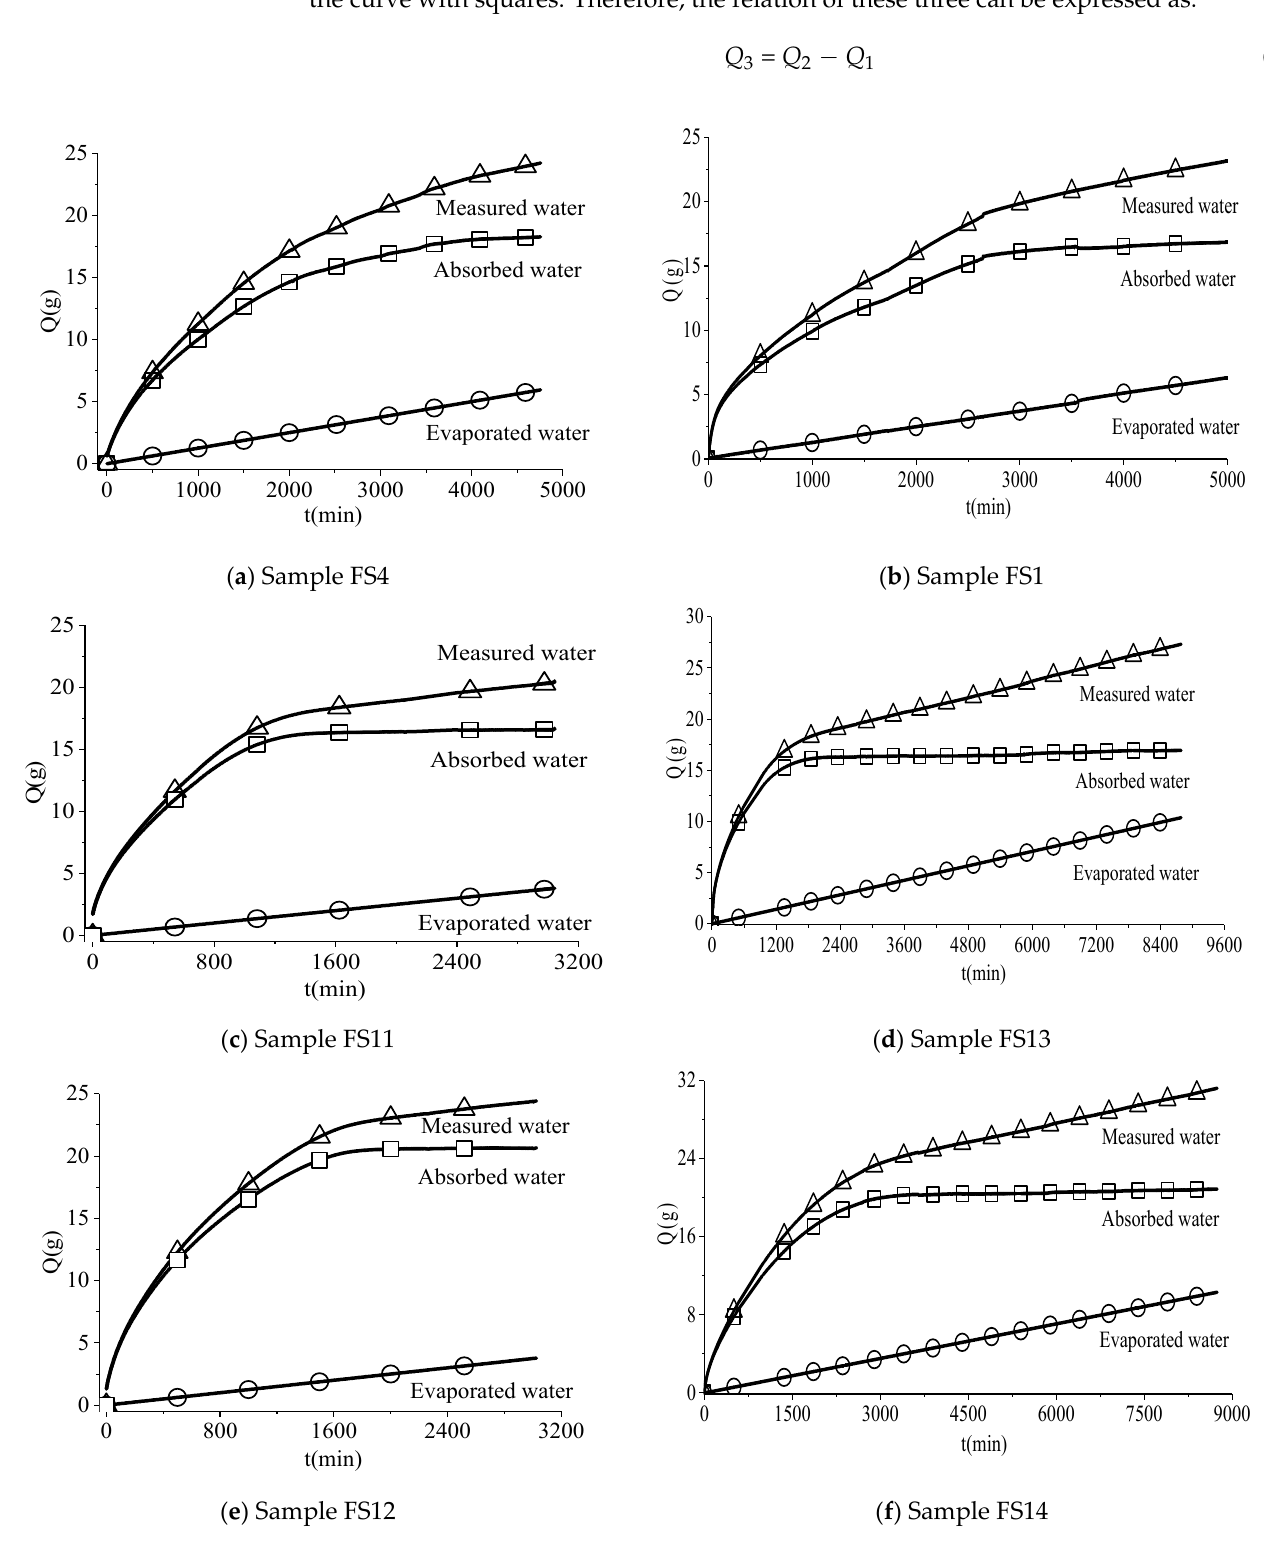
Figure 6. Relationship between water imbibition and time during imbibition test without water pressure.